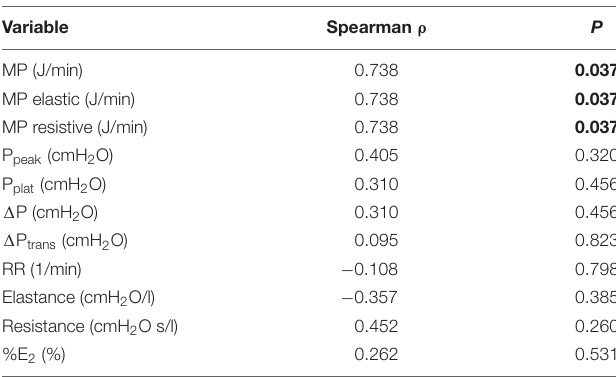
Spearman coefficient ρ for correlation of displayed respiratory variables with (cid:49) K iS . MP, mechanical power obtained from pressure–volume curves; P peak , peak airway pressure; P plat , plateau airway pressure; (cid:49) P, driving pressure; (cid:49) P trans , transpulmonary driving pressure; RR, respiratory rate; %E 2 , percentage of volume- dependent elastance. Statistical test two-sided, significance accepted at p < 0.05. Bold p-values show significant differences (all p-values below